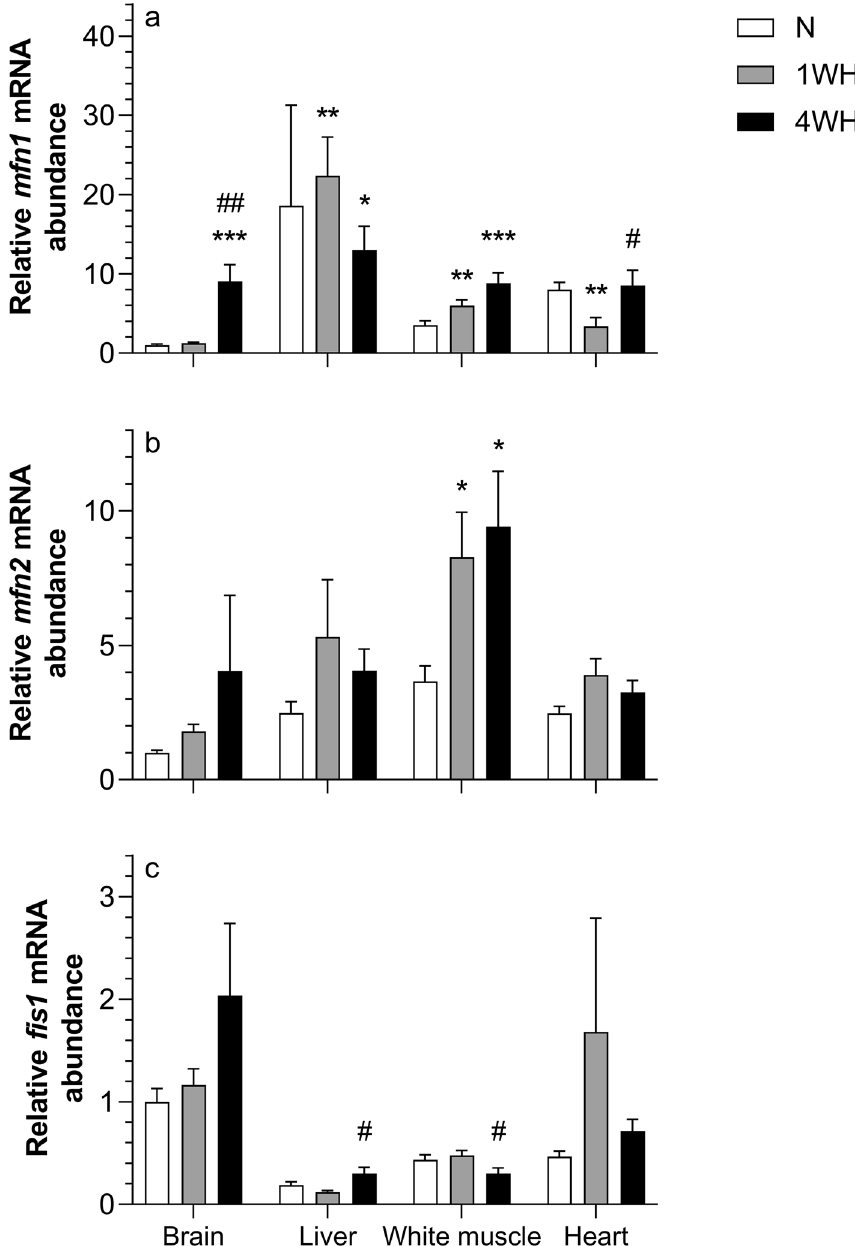
Figure 6. Relative transcript abundance of mRNA targets involved in mitochondrial fission and fusion (( a ) mfn1 ; ( b ) mfn2 ; ( c ) fis1 ) in tissues of normoxic controls (N), 1-week hypoxic (1WH) and 4-week hypoxic (4WH) goldfish. Values are means ± standard error of the mean (s.e.m.); sample size = 7–12 per group. Differences between normoxia and chronic hypoxia are indicated as *( p < 0.05), **( p < 0.01) and ***( p < 0.001). Differences between 1 and 4WH are indicated as #( p <